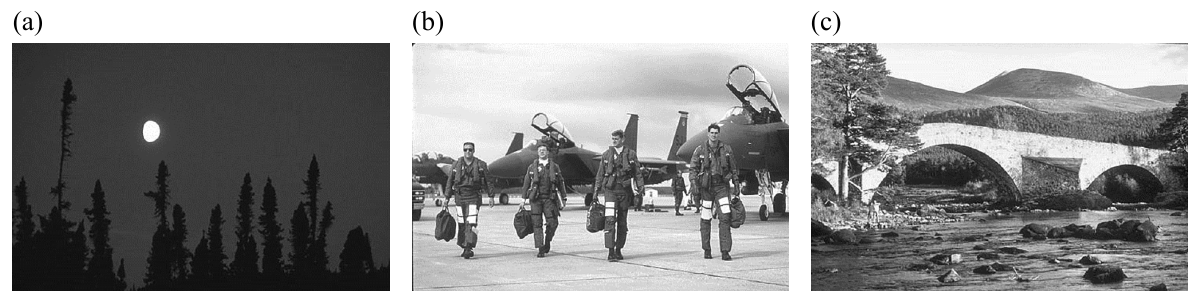
Fig. 3. An example of images for analysis: (a) with low detail, (b) with medium detail, (c) with high detail.